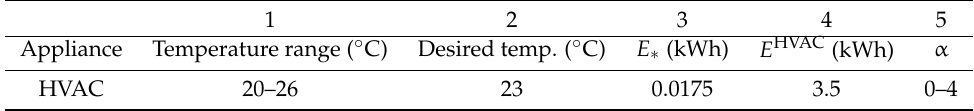
Table 4. HVAC parameters [34].